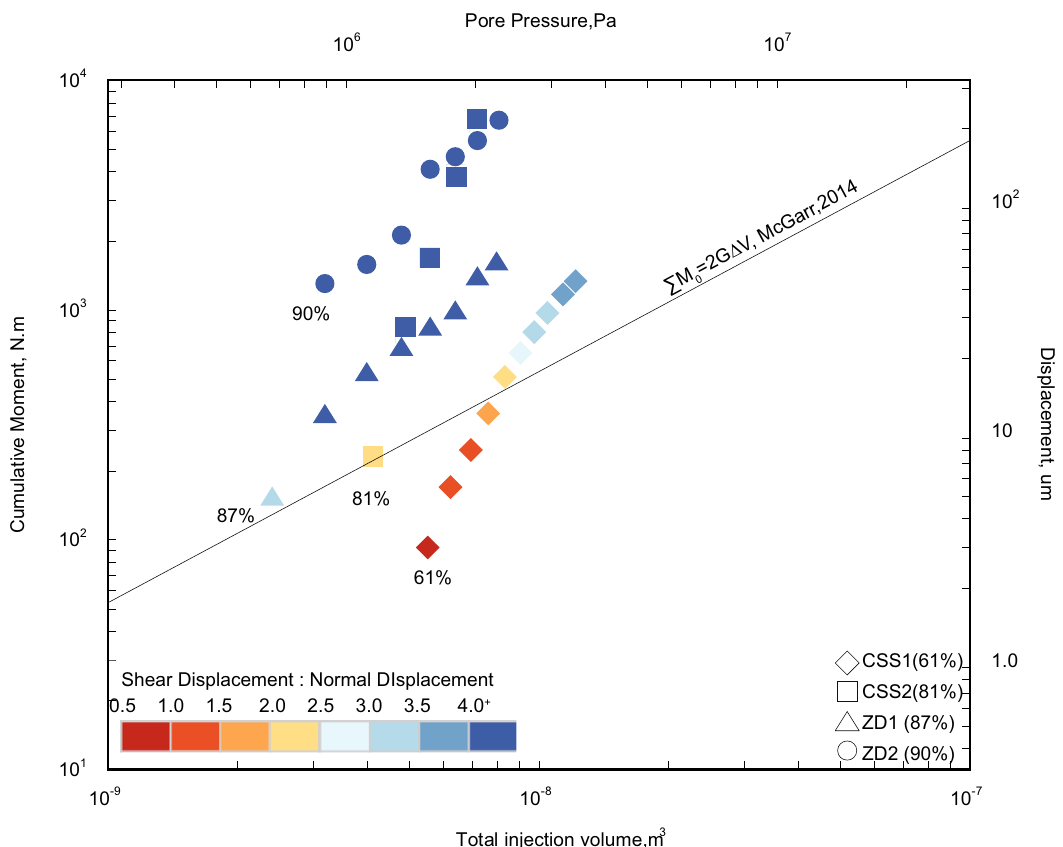
Fig. 4 Cumulative moment magnitude versus total injection volume for all fl uid pressurization steps in our experiments. Symbol colors from hot to cold represent an increasing ratio of slip displacement to fault dilation. Speci fi cally, in CSS1, the cumulative moment magnitude exceeds the classic limit when this ratio is >2. Initial stress ratios τ / τ p are shown as